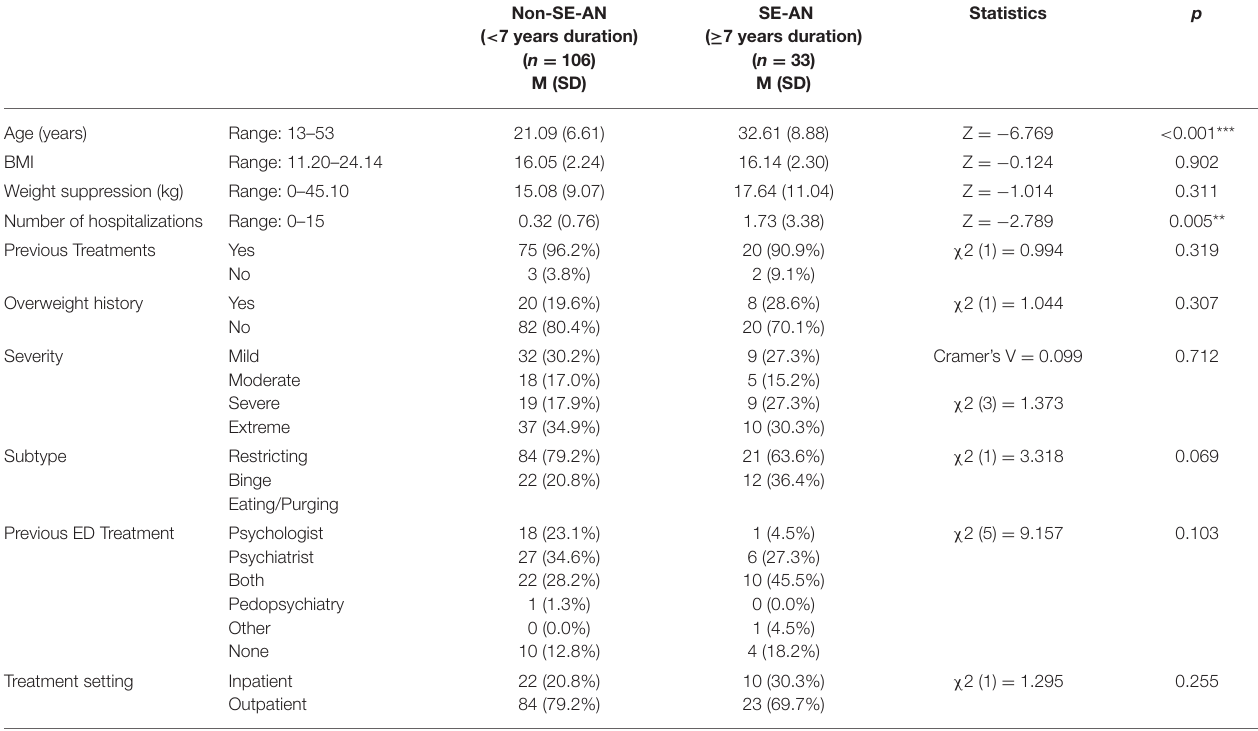
TABLE 1 | Group differences in clinical and demographic characteristics, comparing “Non-SE-AN” and “SE-AN” groups.